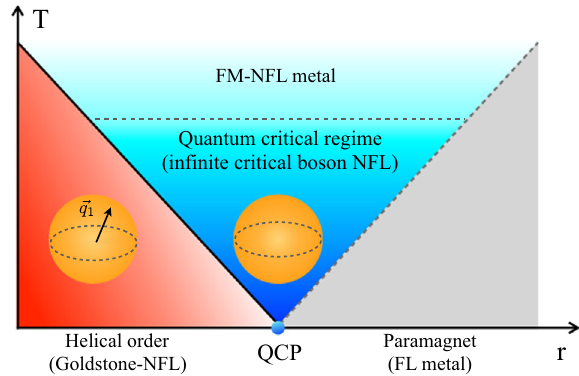
Fig. 2 The global phase diagram. The left corner is a helimagnet and a Goldstone-NFL where the NFL is induced by the gapless Goldstone boson. The right corner is a paramagnet and Fermi liquid metal. The central region is the quantum critical regime where a distinct NFL with in fi nite critical bosons on the boson surface is realized. As the temperature rises to the point where the thermal fl uctuation submerges the boson surface, the system experiences a crossover to a FM criticality-like NFL behavior. The solid (dashed) line refers to the phase transition (thermal crossover).